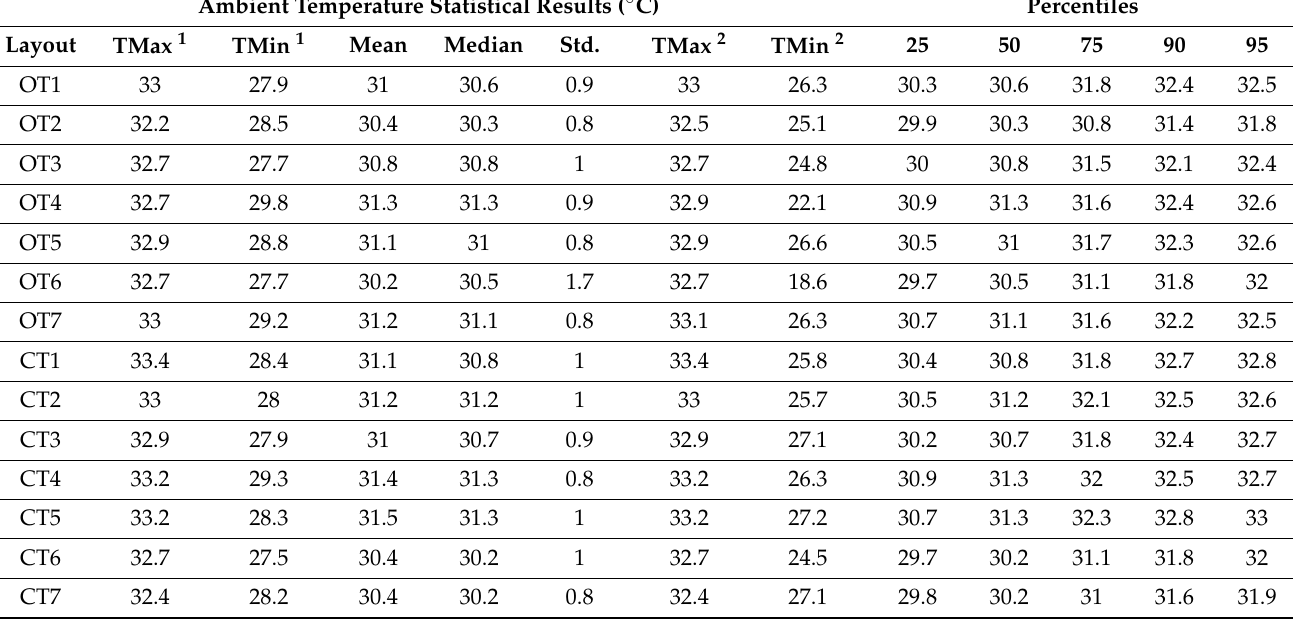
Table 10. Statistical summary of the ambient temperature results at 14:00 for all precincts.